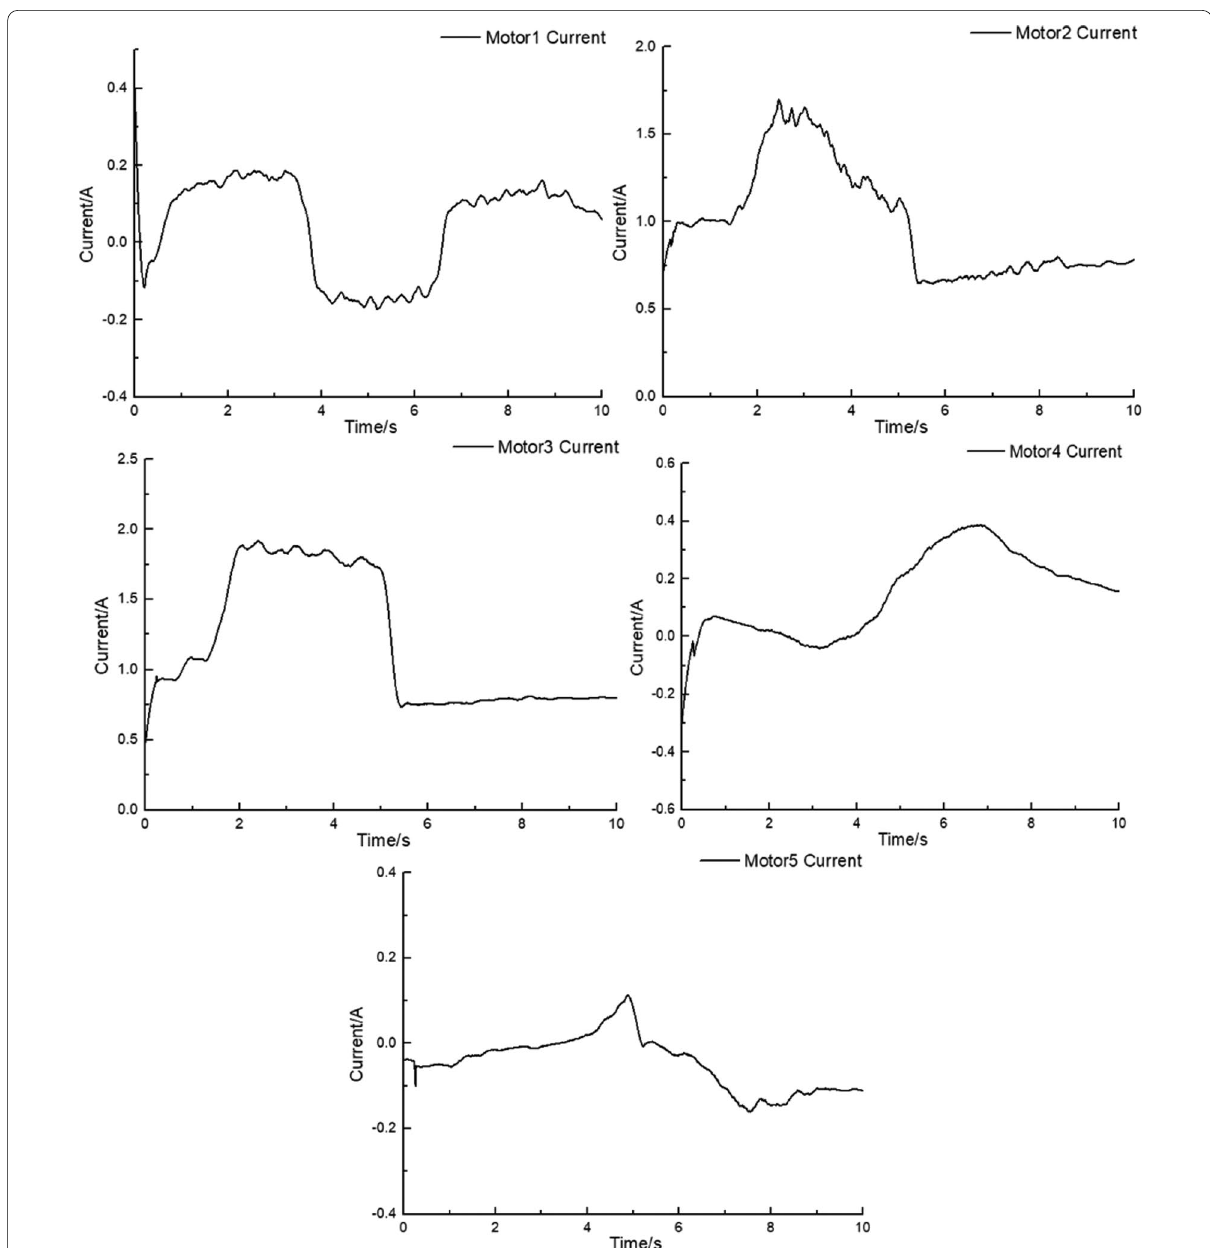
Figure 7 Measured driving current of each